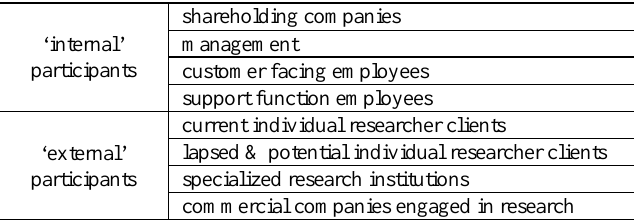
Table 3: Person sample